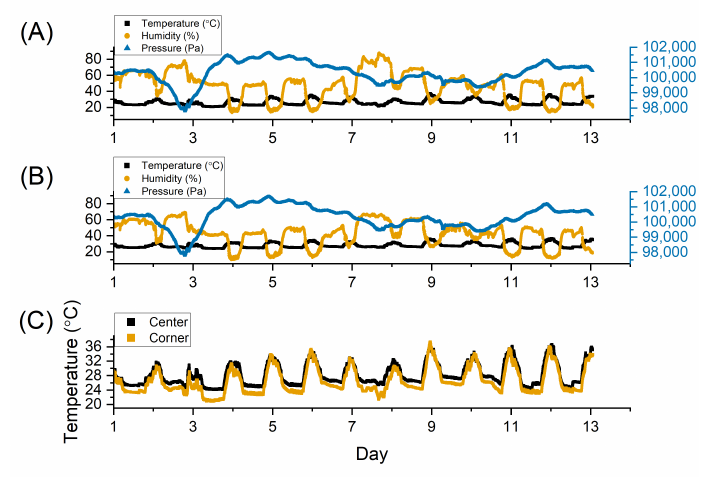
Figure 8. The environmental conditions as measured in the corner of a greenhouse ( A ) and the center of a greenhouse ( B ) with the temperatures of the two locations compared ( C ).